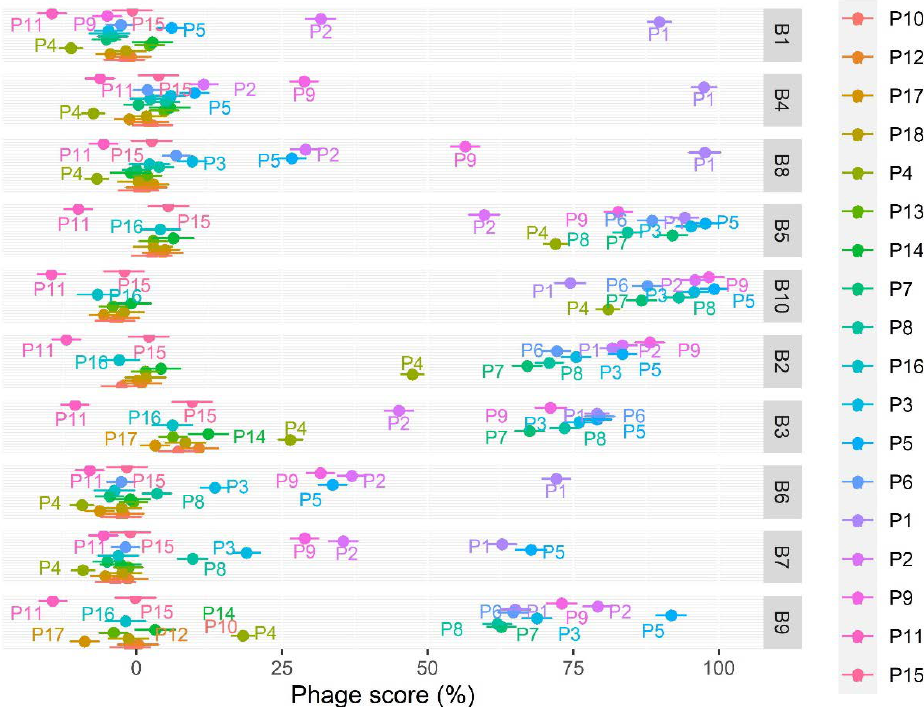
Figure 3. PhageScore average by bacteria and phage. A higher PhageScore correlates with a higher efficiency of the phage and higher bacterial growth reduction. A total of 2869 phage–host combination experiments were included. The standard error is shown.